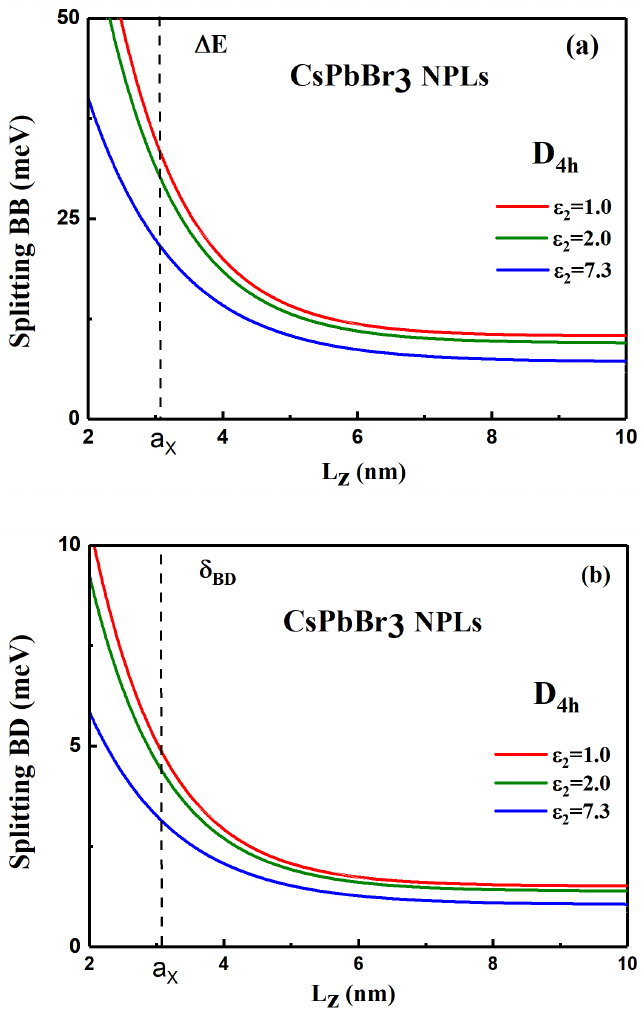
Figure 5. ( a ) Bright–bright splitting ∆ E and ( b ) bright–dark splitting δ BD , in CsPbBr 3 NPLs with a tetragonal symmetry and different dielectric mismatches (the outside dielectric constant ε 2 varying from 7.3 to 1). The vertical line indicates a size comparable to the exciton Bohr